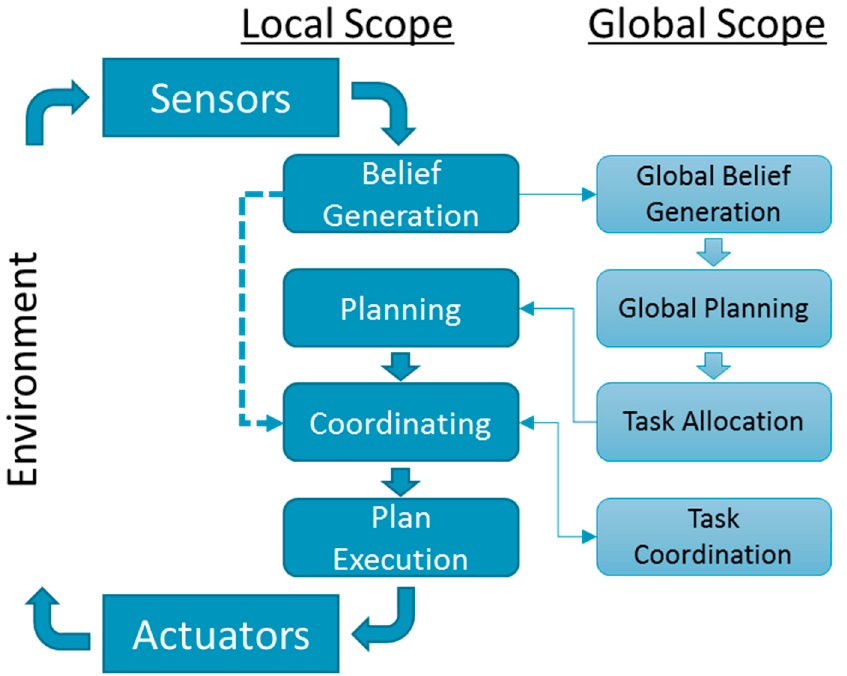
Figure 3. A general control flow of a single robot in an Figure 3. a general control flow of a single robot in an MRS.